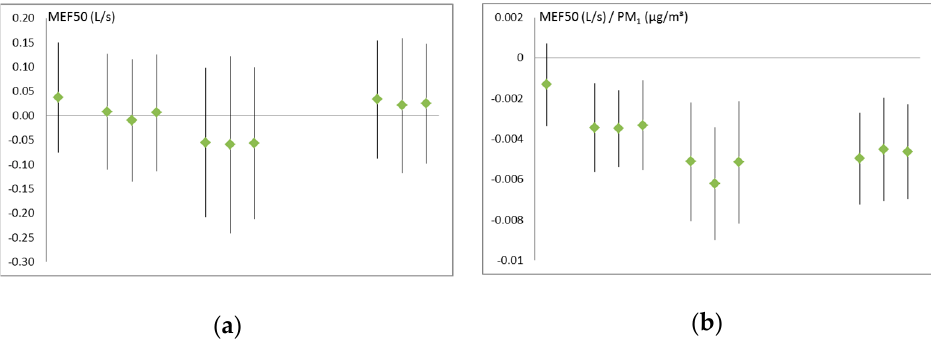
Figure 1. Examples for air pollution effects on MEF50* (in L/s): ( a ) Effect of the setting “road”, controlled for background pollution; ( b ) Effect of PM 1 (µg/m³). Each triplet stands for: unadjusted, adjusted for lung function before exposure, adjusted for exhaled nitrogen oxide (NO) before exposure. The time points are (left to right): Before exposure (one value only), immediately after the walk, 1 h after the walk, and 24 h after the walk. * For Abbreviations please see table A3!